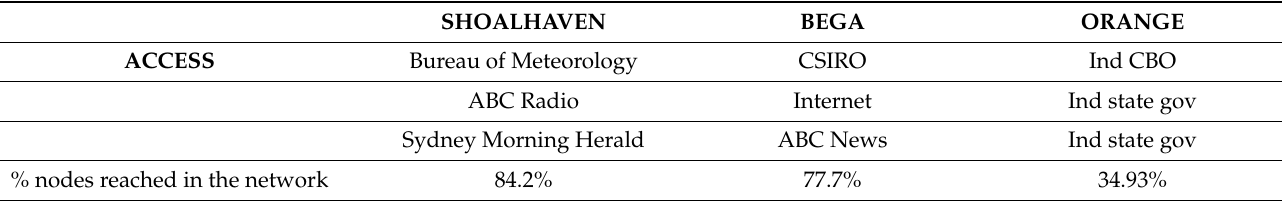
Table 6. Keyplayer access and